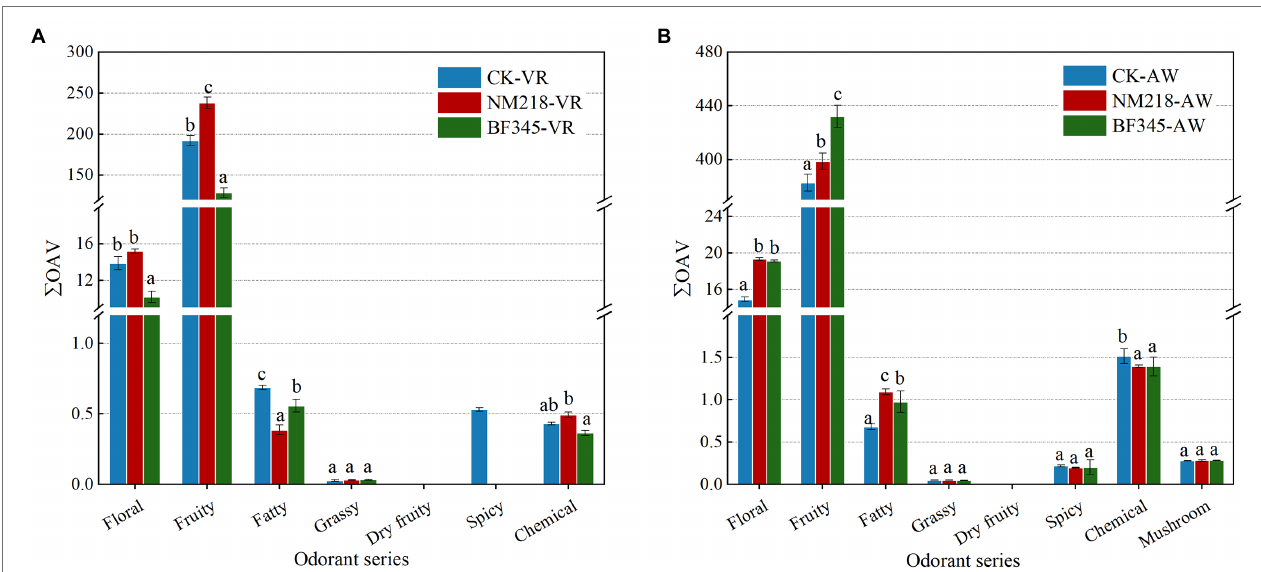
FIGURE 4 | The total odor activity value ( Σ OAV) of volatile aroma compounds in Cabernet Sauvignon and Chardonnay wines. (A) is for Cabernet Sauvignon wines and (B) is for Chardonnay wines. CK-VR; pure culture of S. cerevisiae (VR) used as a control in Cabernet Sauvignon wines. NM218-VR; sequential inoculation of M. guilliermondii NM218 and VR at 48 h in Cabernet Sauvignon wines. BF345-VR; sequential inoculation of H. uvarum BF345 and VR at 24 h in Cabernet Sauvignon wines. CK-AW; pure culture of S. cerevisiae (AW) used as a control in Chardonnay wines. NM218-AW; sequential inoculation of M. guilliermondii NM218 and AW at